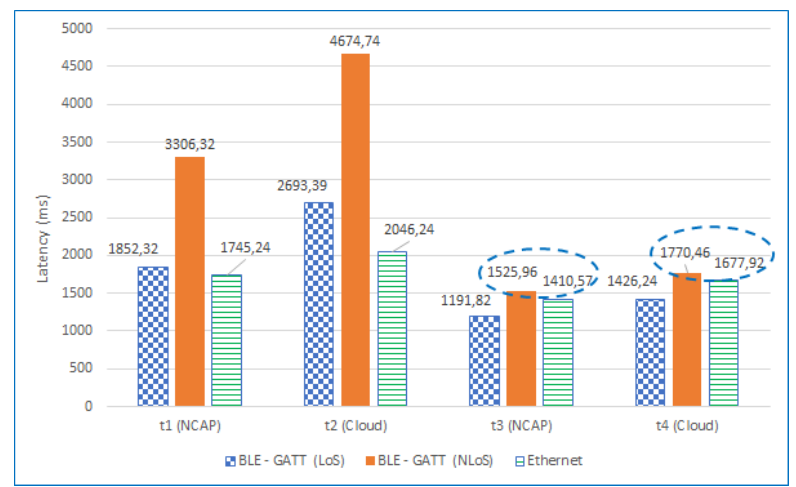
Figure 37. Total latencies for LoS and No Line-of-Sight (NLoS)